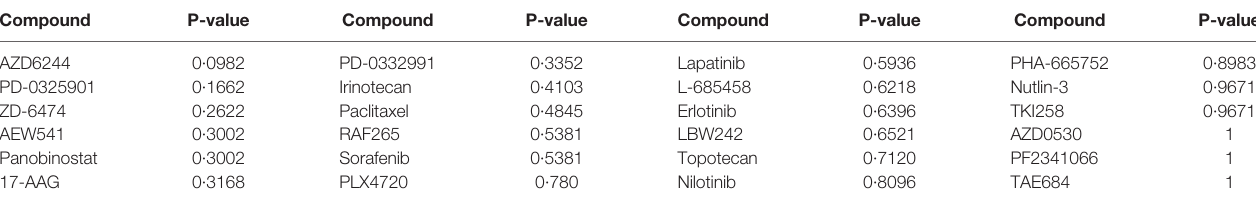
TABLE 4 | The statistical results for 24 anti-cancer compounds using the Wilcoxon rank sum